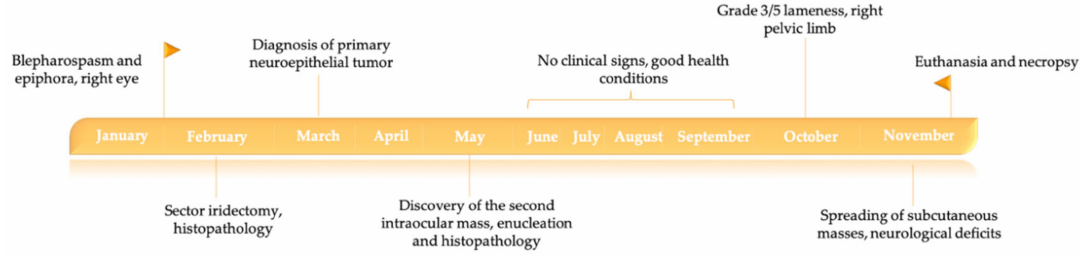
Figure 2. Timeline of the case history.